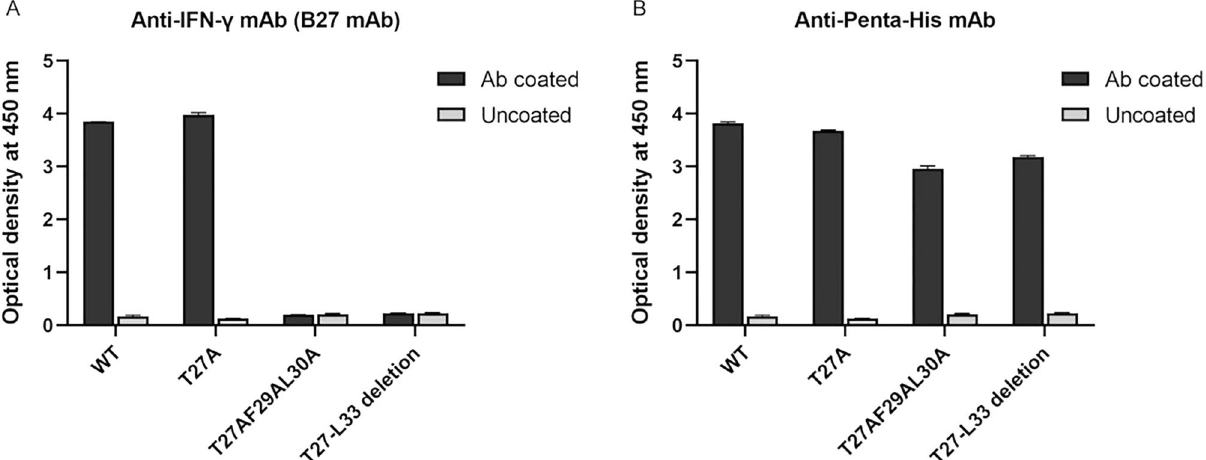
Figure 8. Reactivity of B27 mAb to IFN-γ WT and mutants using sandwich ELISA. ( A ) IFN-γ was captured by B27 mAb and monitored by HRP-conjugated anti-6 × His mAb ( B ) IFN-γ was captured by anti-Penta- His antibody and monitored by HRP-conjugated anti-6 × His mAb. Three technical replicates of all ELISA experiments were performed, and data are shown as mean ±